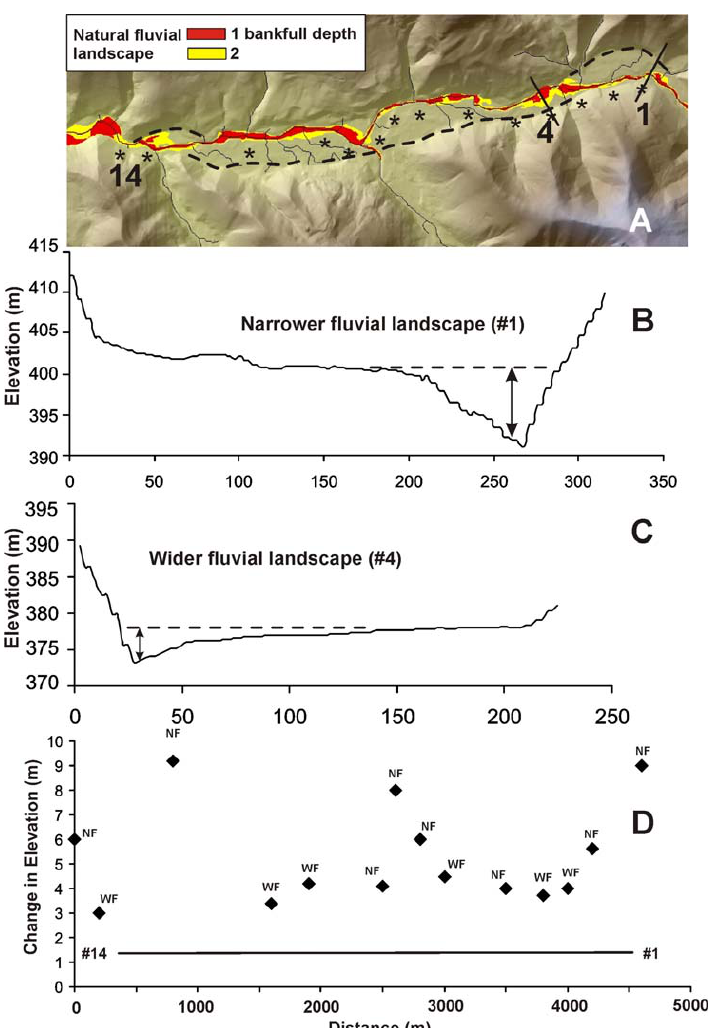
Fig. 7. The narrow east-west trending valley in the upper West Fork (H, Fig. 4) contains terrace and fan deposits that create alternating wide and narrow fluvial landscapes (A) . In the lower panel (D) , the change in elevation corresponds to the elevation difference between the channel and bounding landforms, as illustrated in (B) and (C) ; NF and WF indicates “narrow fluvial landscape and “wider fluvial landscape, respectively”. “*” on the upper panel denotes locations of the cross sections 1 through 14, from right to